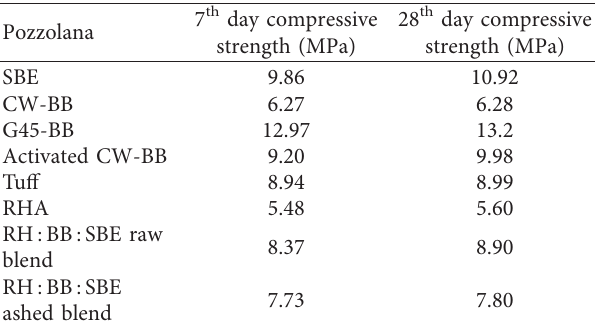
Table 3: Compressive strength of pozzolana-lime cements at 7 th and 28 th day of